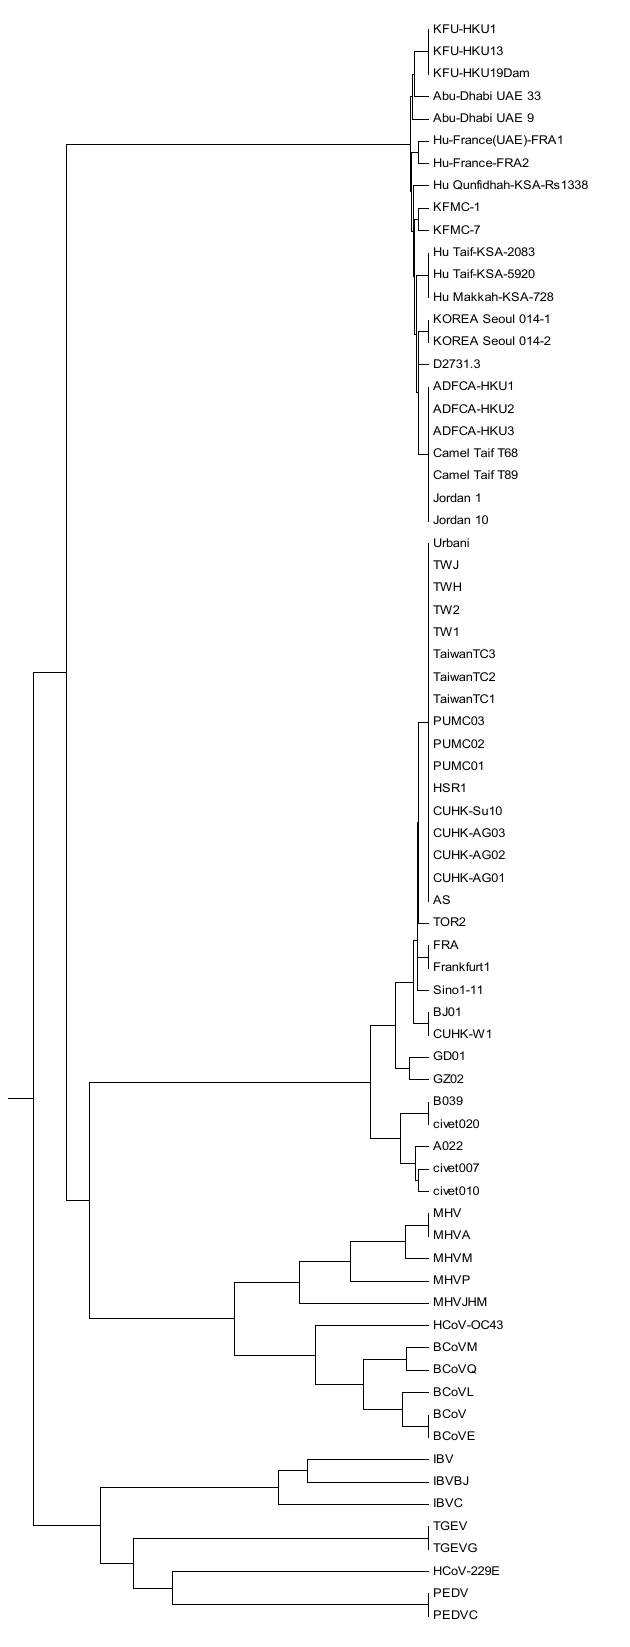
Figure 3. The relationship tree of 72 coronavirus spike proteins.